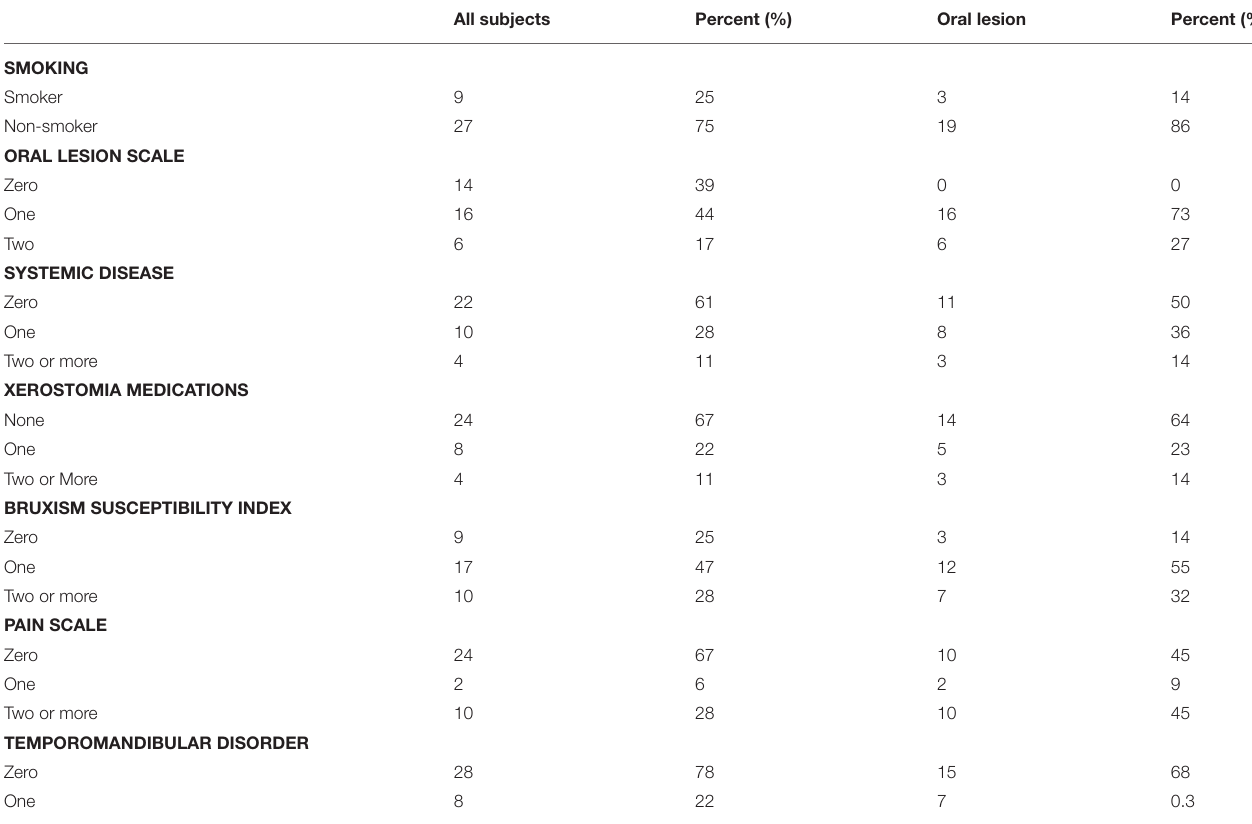
TABLE 2 | Distribution of health